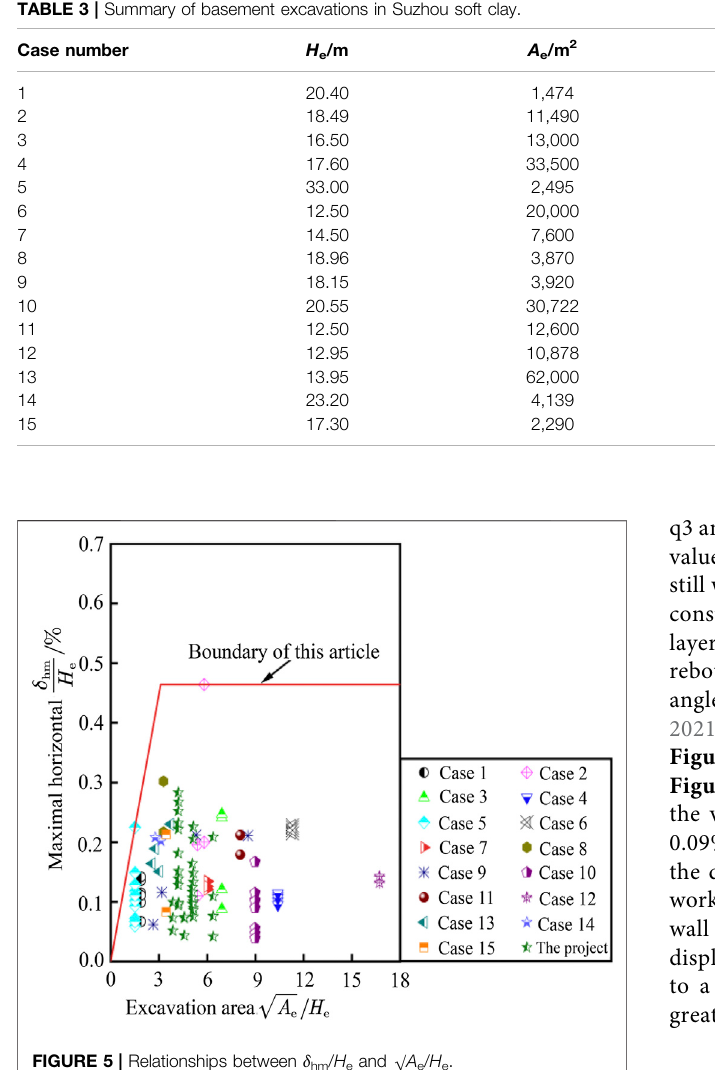
FIGURE 5 | Relationships between δ hm / H e and √ A e / H e .